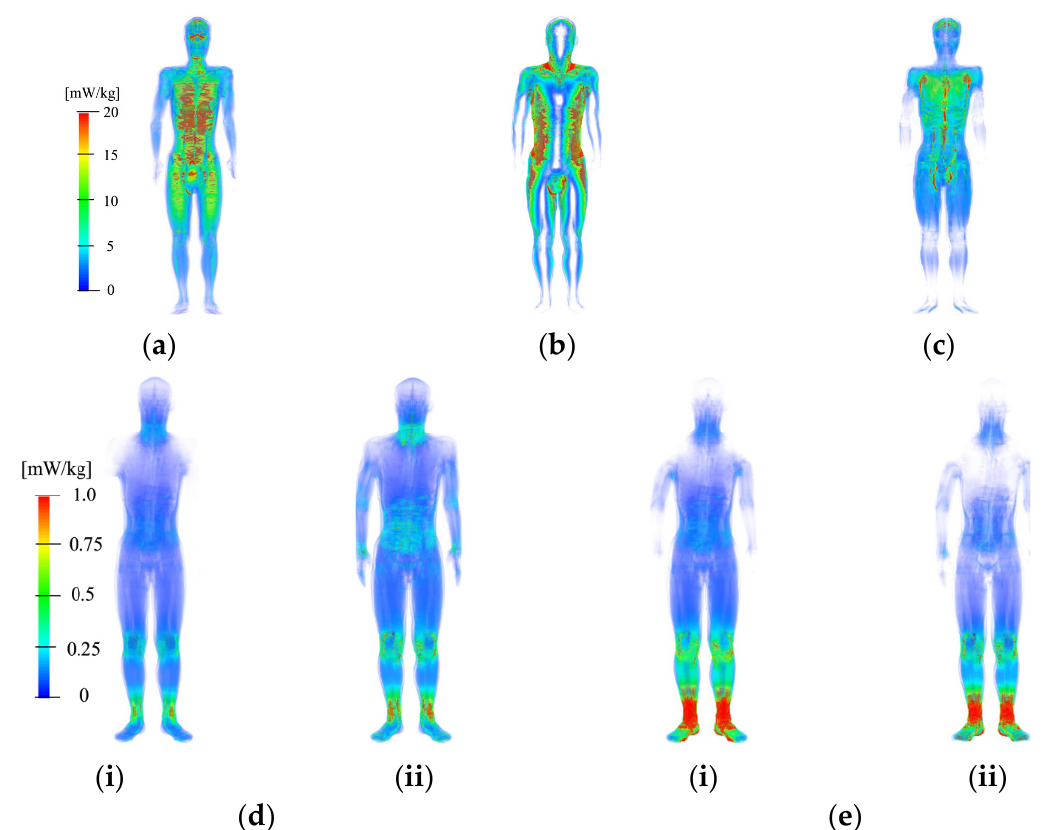
Figure 12. SAR distributions in TARO (Japanese adult male model) standing in free space for magnetic field exposure at 10 MHz. The exposure directions are ( a ) LAT, ( b ) AP, ( c ) TOP, ( d ) free space at 60 MHz, and ( e ) grounded at 30 MHz for ( i ) electric field, and ( ii ) plane wave exposure.